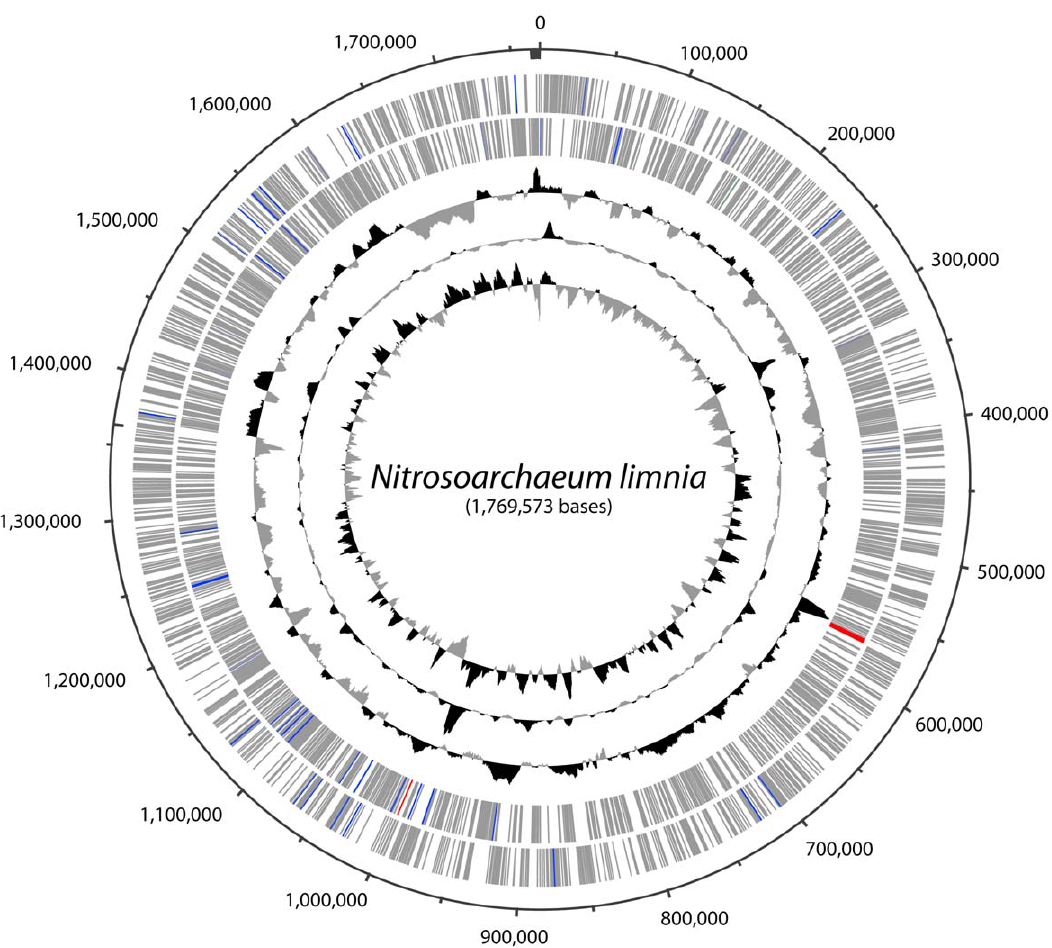
Figure 3. Circular representation of the N.limnia genome. From the outer ring to the inner ring: Scaffold breakpoints are indicated by the inside tick marks, predicted genes on the forward strand, predicted genes the reverse strand, G + C content, GC skew, and GGGT skew. On the outer two rings, protein coding sequences are colored gray, tRNA genes in blue, rRNA genes in red, and noncoding RNA genes in green.